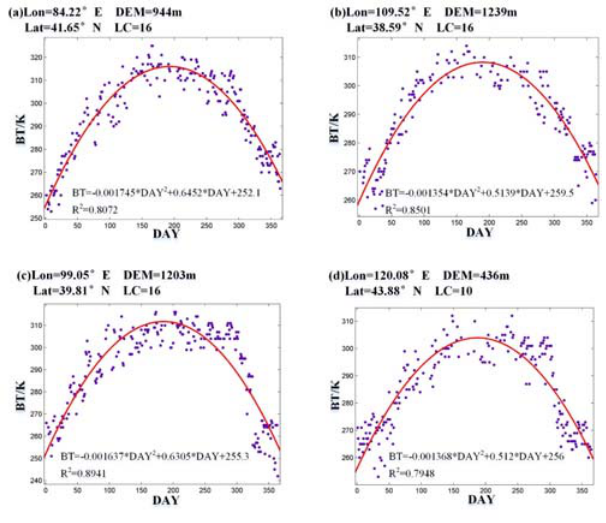
Figure 4. The regression curves of temperature change in 2006 Based on the brightness temperature series data of the whole 2006 from FY-2C VISSR, in figure 4, the evolution of BT follows a parabolic curve with the season and the symmetry axis is approximately 190 days, which corresponds to late July. influence function can be rewritten as one simple